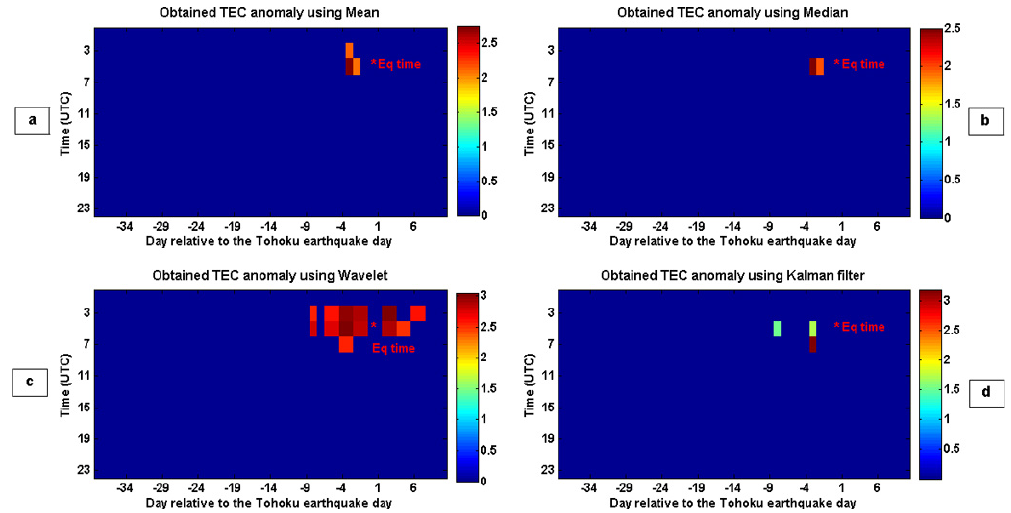
Fig. 15. Result of analysis for the Tohoku earthquake showing detected TEC anomaly using methods (a) mean, (b) median, (c) wavelet transform and (d) Kalman filter during quiet geomagnetic conditions. The x-axis represents the day relative to the Tohoku earthquake